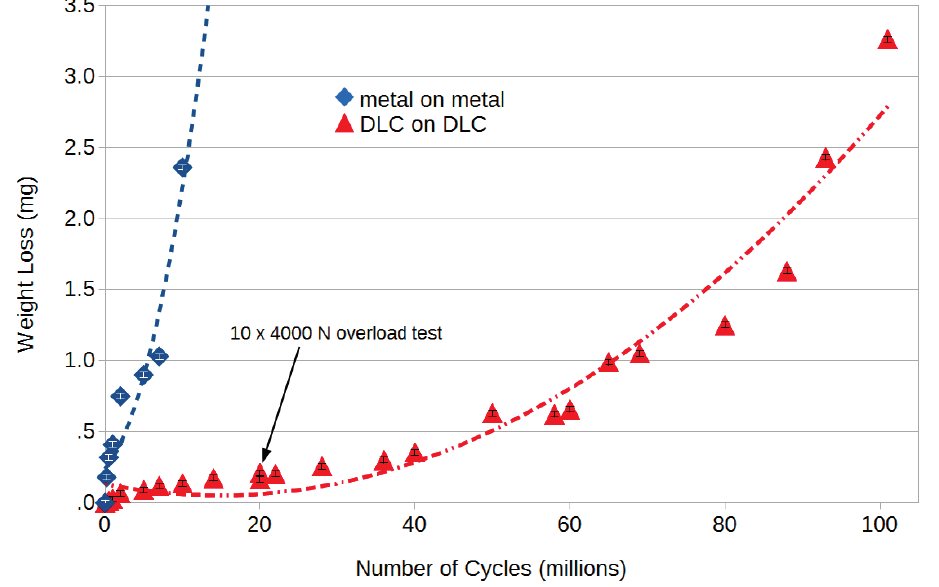
Figure 1. Gravimetrically measured weight loss over 100 million cycles (simplified simulator setup) with comparison to an uncoated (metal-on-metal)